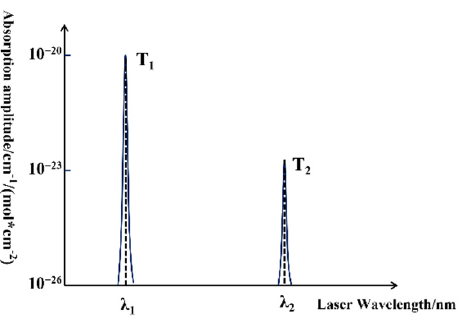
Figure 3. Target absorption lines of water vapor and heavy oxygen water vapor.